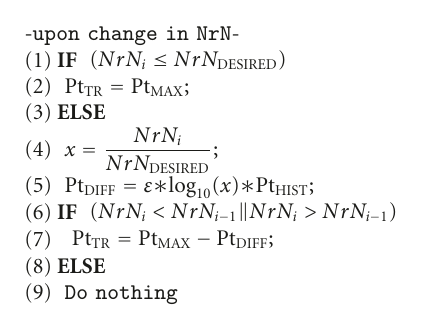
Algorithm 4: Basic power control